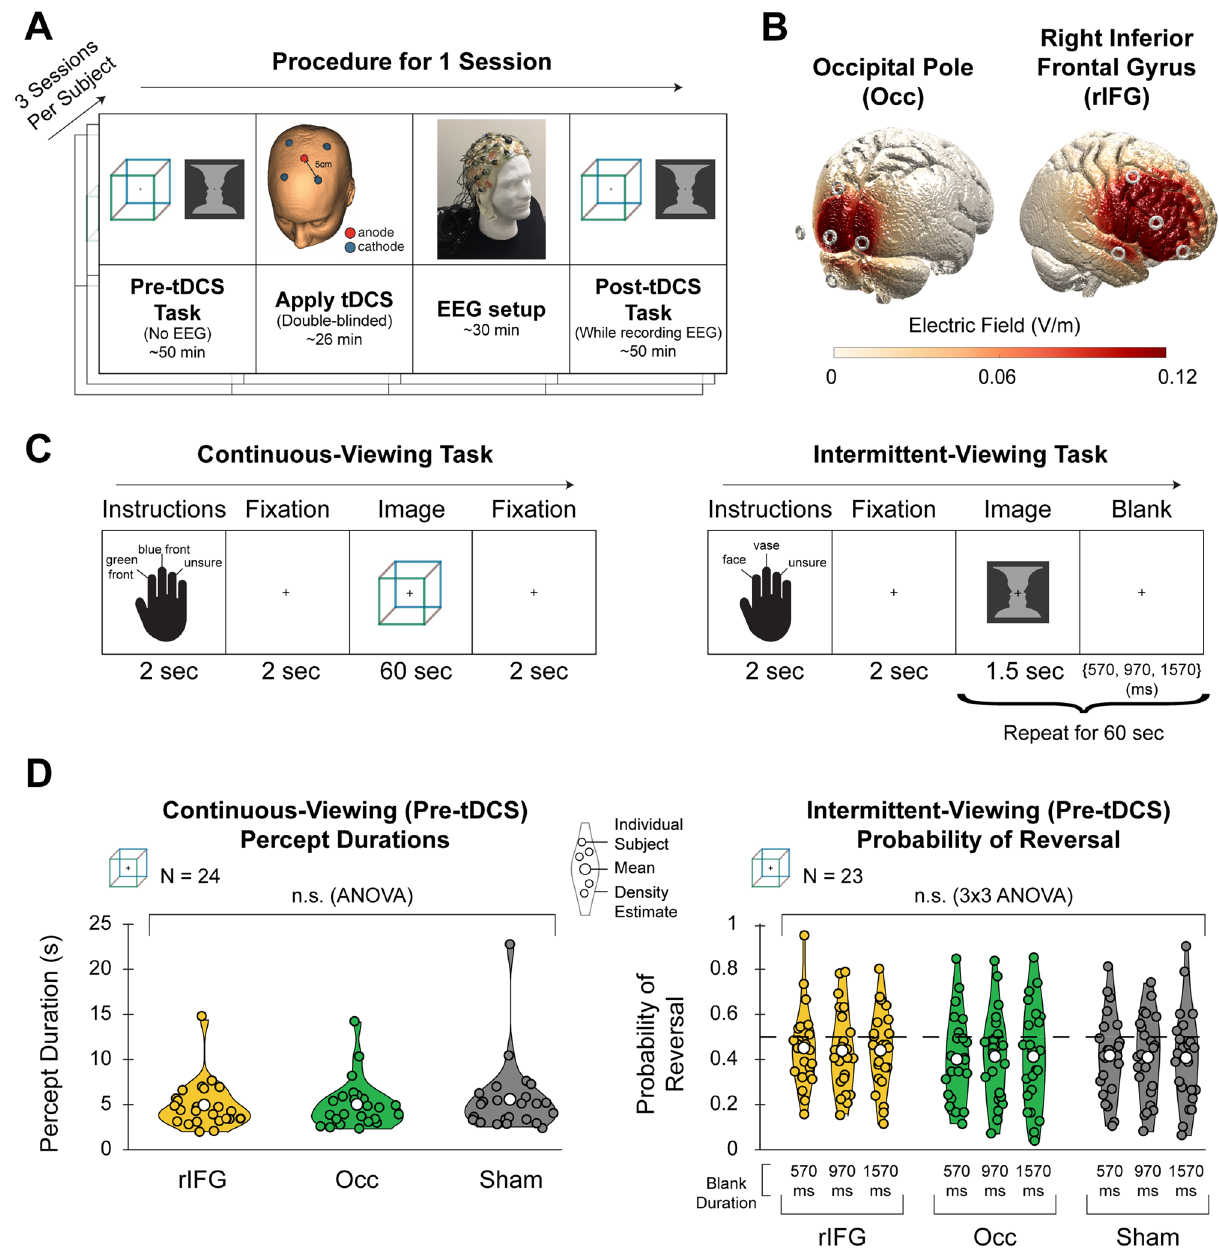
Figure 1. Experimental procedure and pre-tDCS behavioral results. ( A ) Each subject underwent the experiment on three different days. On each day, the experiment only differed in two possible ways: the region of tDCS stimulation and whether active or sham stimulation was applied. The experimental procedure on each day consisted of 4 steps: (1) Subject performed pre-tDCS task, (2) Double-blinded tDCS was applied over the target region, (3) tDCS cap was removed and the EEG cap was prepared, (4) Subject performed post-tDCS task under EEG recording, which used the exact same task structure as the pre-tDCS task. ( B ) The two target regions used, occipital pole (Occ) and right inferior frontal gyrus (rIFG), and estimates of the electric field over the cortex when applying 2.0 mA tDCS current; image generated using ROAST toolbox from 28 . ( C ) Subjects performed two task conditions: continuous-viewing ( Left ) and intermittent-viewing ( Right ). For both task conditions, half of the trials presented the Necker cube image and the other half presented the Rubin face-vase image. ( D ) Violin plots of behavioral data across subjects for cube trials in the pre-tDCS task (face-vase trials shown in Fig. S1A). Dotted line for intermittent-viewing data ( Right ) indicates 0.5 probability of reversal. The cube image was created by one of the authors (B.J.H.); the face-vase image was adapted from a figure in 29